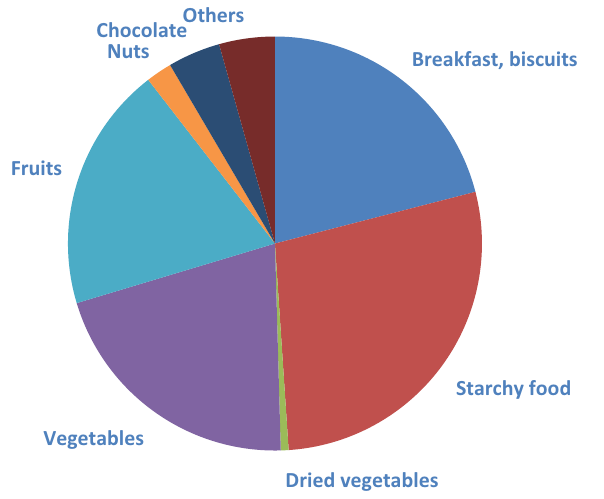
Figure 2. Origin of consumed dietary fibers at baseline